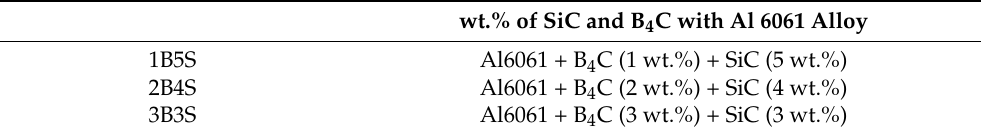
Table 3. Al6061 hybrid composites with different proportions of SiC and B 4 C